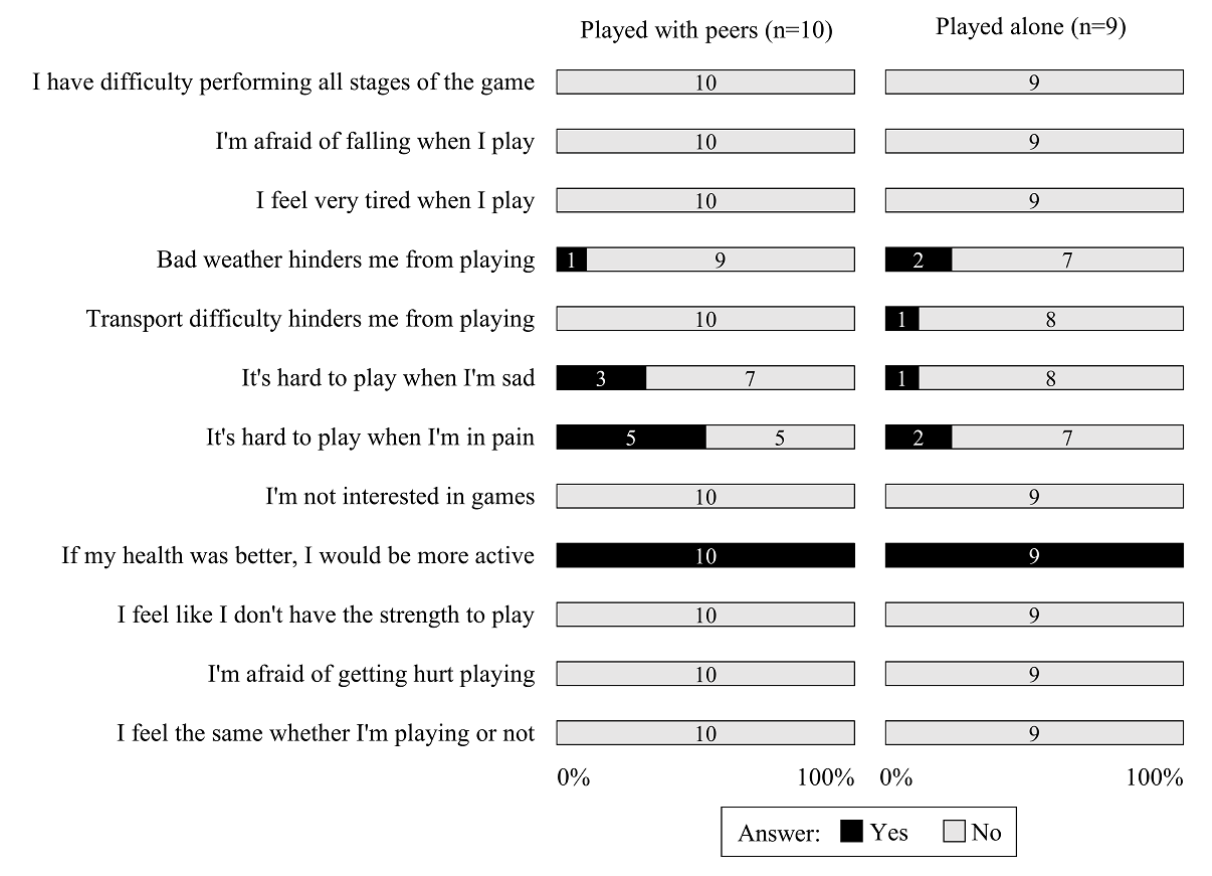
Figure 2. Responses to the adherence statements about barriers when playing the bowling